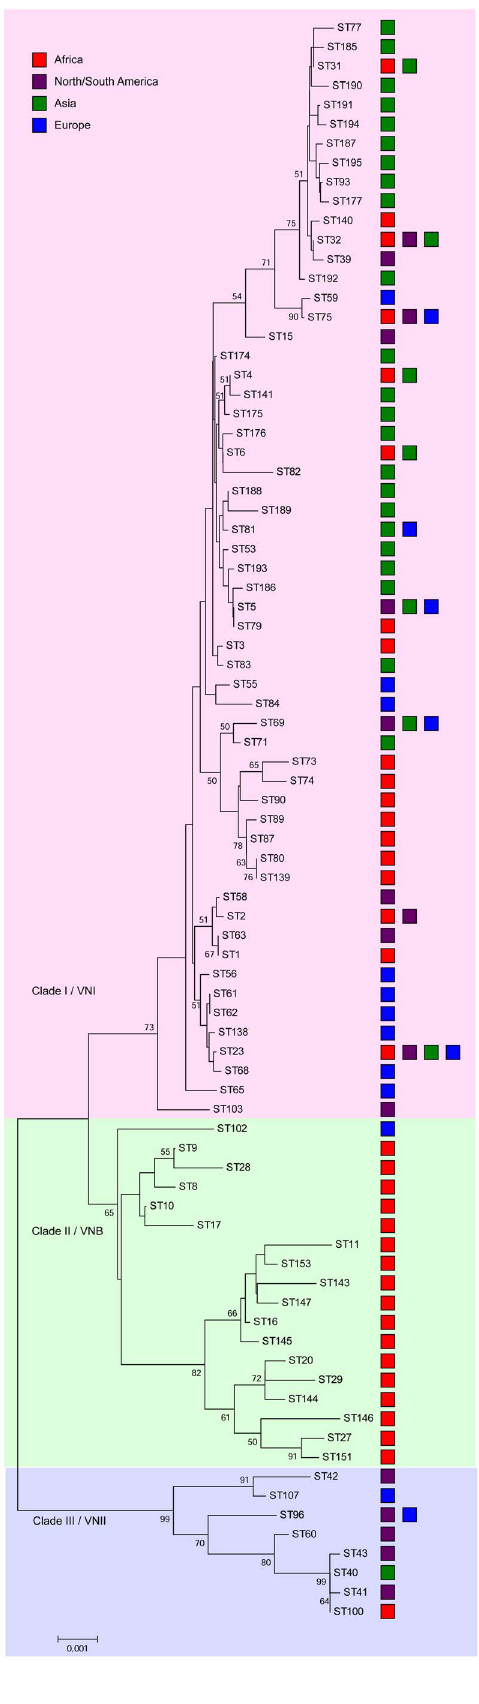
Figure 3. Unrooted Neighbor-joining phylogenetic analysis of the concatenated sequences of each sequence type (ST) found among the global isolates. Numbers at each branch indicate bootstrap values . 50%, based on 1,000 replicates. Each color rectangle represents the geographic origin of